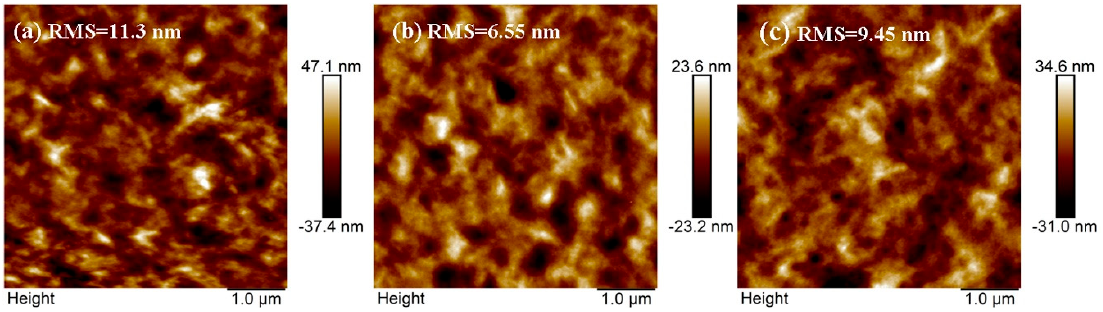
Figure 6. Atomic force microscopy (AFM) tapping mode height images the surface of (a) ITO/P3HT:PC 61 BM, (b) ITO/ PDIPN /P3HT:PC 61 BM and (c) ITO/ PDIPNSO 3 Na /P3HT:PC 61 BM.